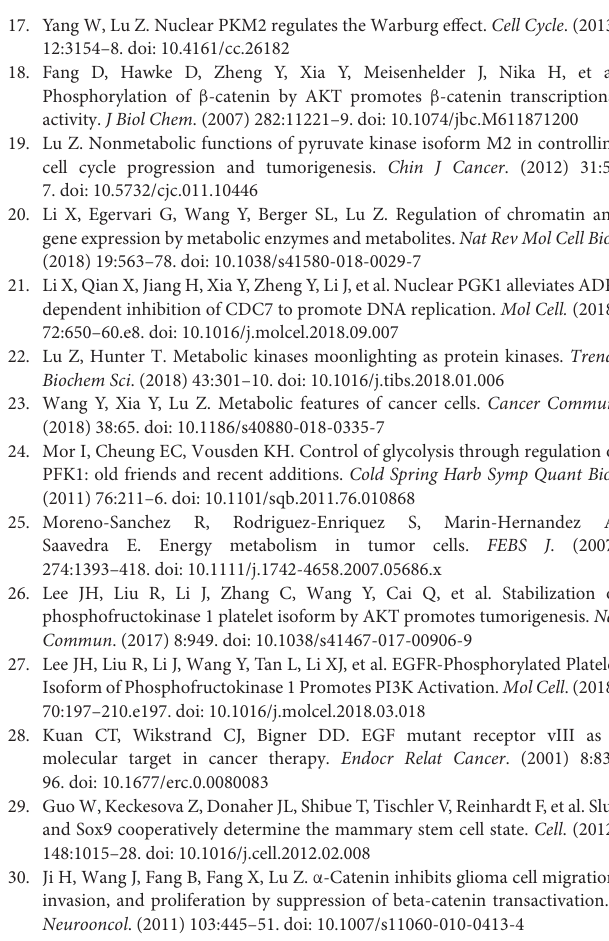
Supplementary Figure S2 | Inhibition of glycolysis does not reduce EGF-induced AKT phosphorylation or c-Myc expression. U251 cells were pretreated with DMSO (Control) or 2-DG (10mM) for 2h and then the cells were treated with or without EGF (100ng/ml) for the indicated periods of time. Immunoblotting analyses were performed with the indicated